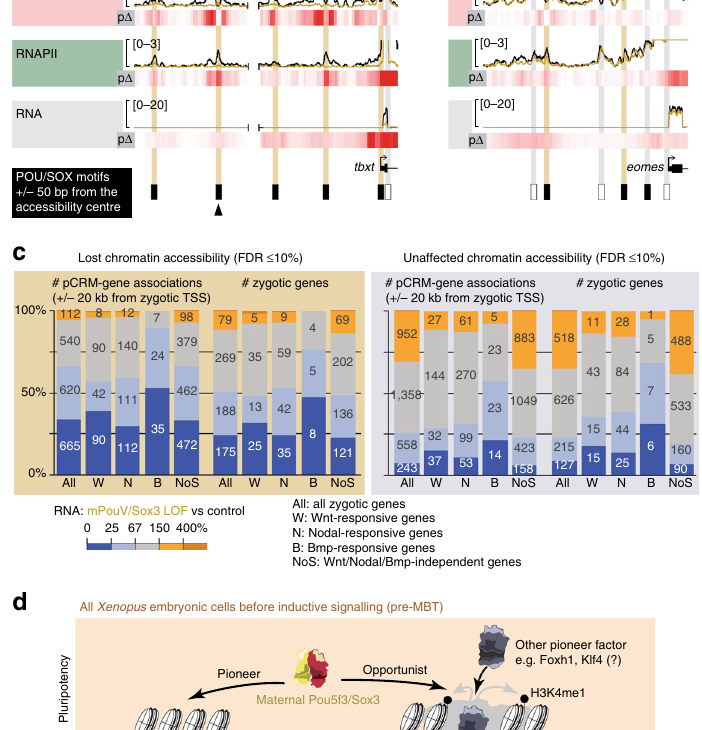
All W N B NoS All W N B NoS